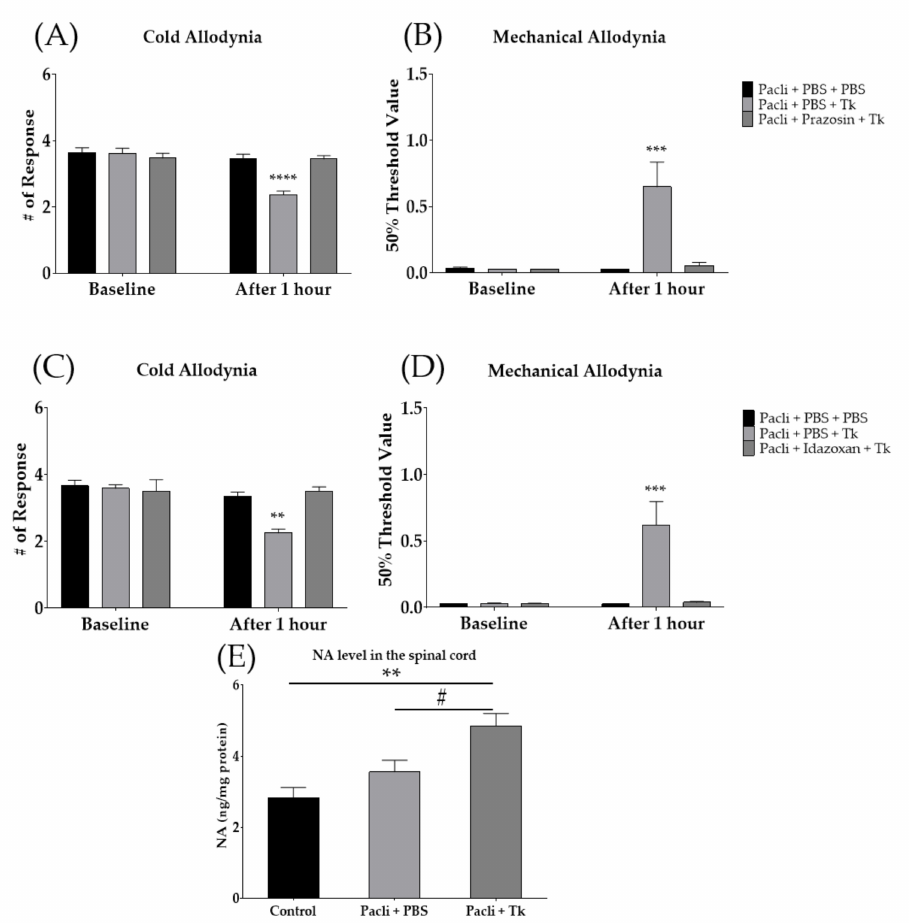
Figure 6. Involvement of spinal noradrenergic system in the anti-allodynic effect of Tk. The effect of intrathecally injected prazosin ( α 1 -adrenergic-receptor antagonist) ( A , B ) and idazoxan ( α 2 -adrenergic- receptor antagonist) ( C , D ) on the effect of Tk. Changes in noradrenaline (NA) contents in the spinal cord following 1 h of Tk (500 mg/kg) oral administration ( E ). PBS was used as a control to prazosin, idazoxan and Tk ( A – E ). Control is mixture of 50% EtOH and 50% Cremophor EL solution (1:1) treated group as a control of Pacli + PBS ( E ). Pacli: paclitaxel, Tk: Trichosanthes kirilowii Maximowicz.